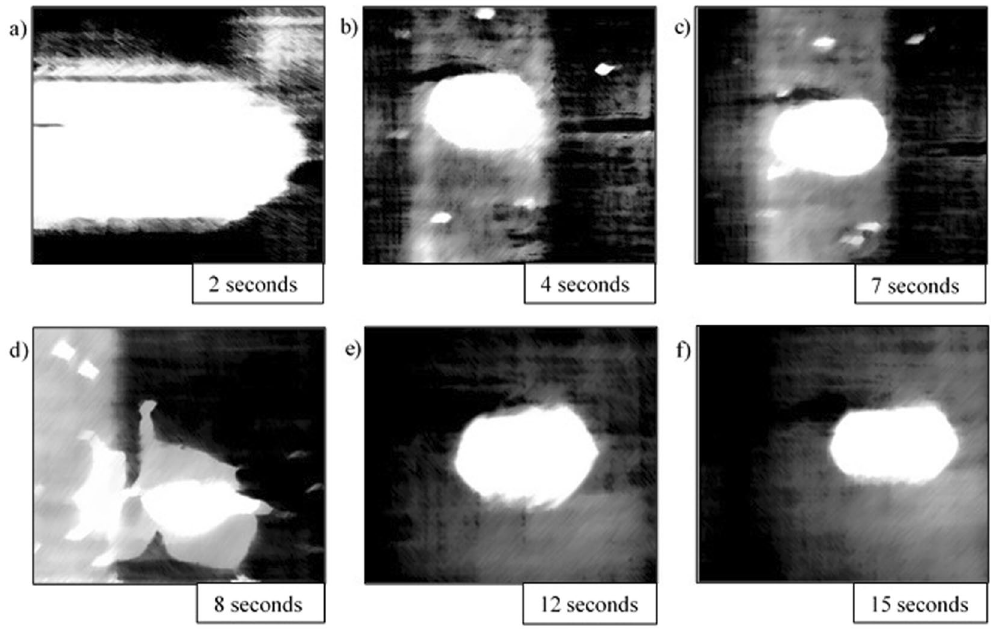
Figure 6. Time step images of the 3% FeAl experiment as seen in the HT-CSLM. In focus metal phases appear as lighter in grey scale and the molten metal oxide phase is seen as black. ( a–f ) Shows the cycle of perturbation growth with no emulsification